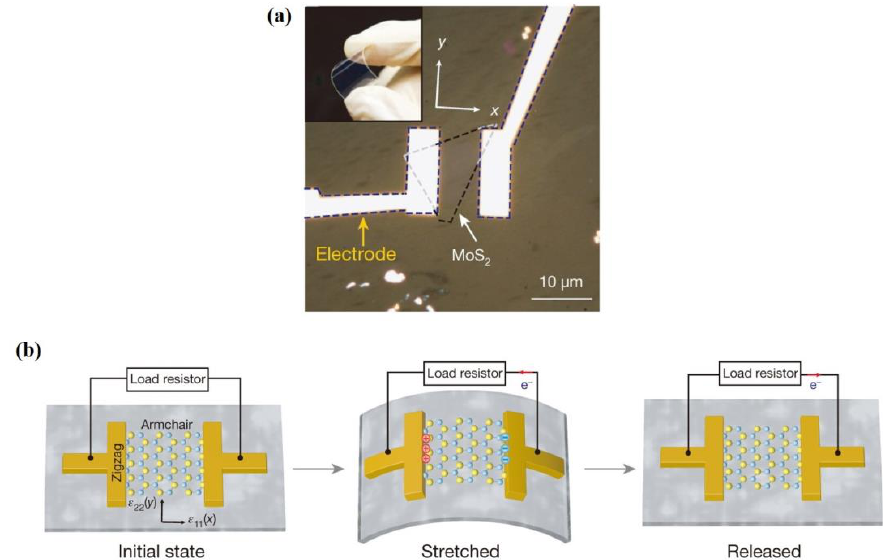
Figure 6. ( a ) Flexible electronic devices based on single layer MoS 2 thin films [71]. Reproduced with